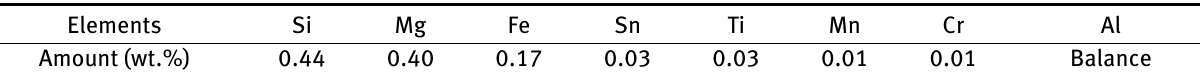
Table 1: Chemical compositions of Al 6063 alloy. Elements Amount (wt.%)